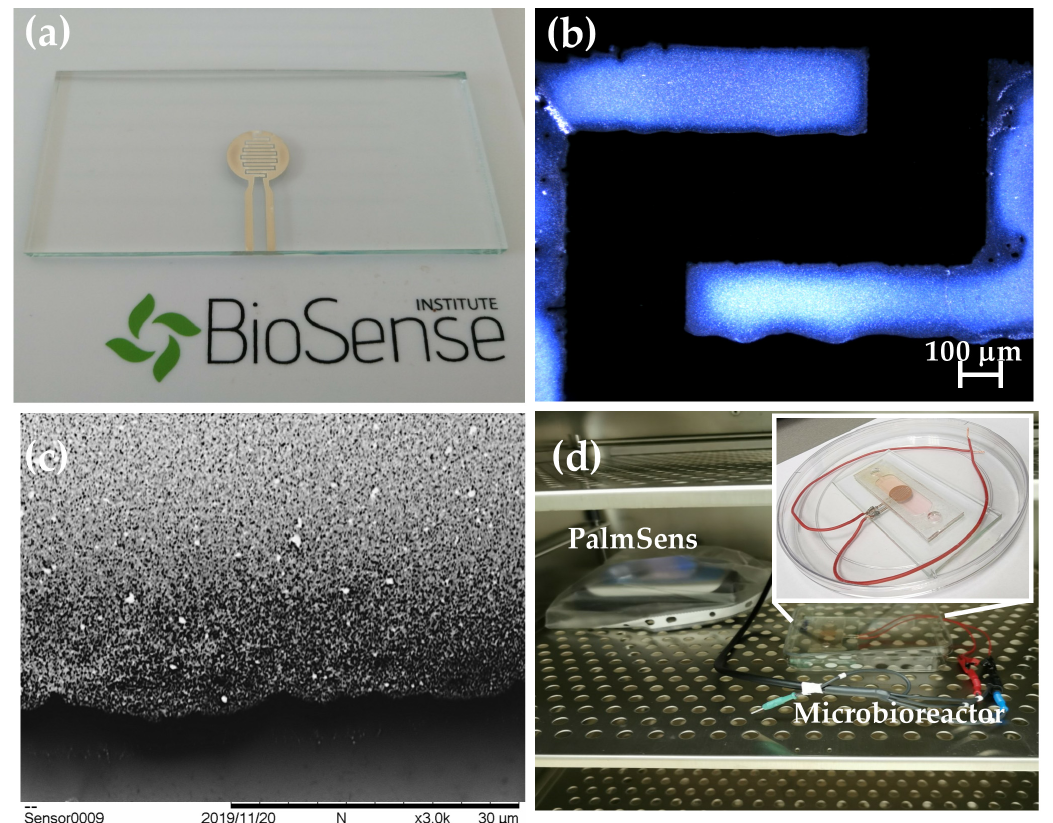
Figure 3. ( a ) Inkjet-printed impedimetric sensor on the glass substrate. ( b ) Profile image of the inkjet- printed IDE. ( c ) SEM image of the inkjet-printed IDE at a magnification of 3000 × . ( d ) Experimental setup. A portable potentiostat PalmSens was placed inside of the CO 2 incubator, together with a microbioreactor with an impedimetric sensor.